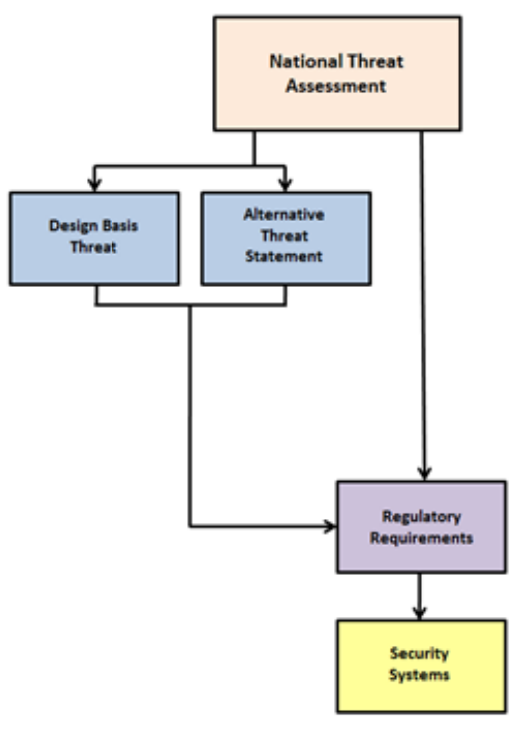
Figure 1: IAEA Revised NSS 11 Process for Using Threat